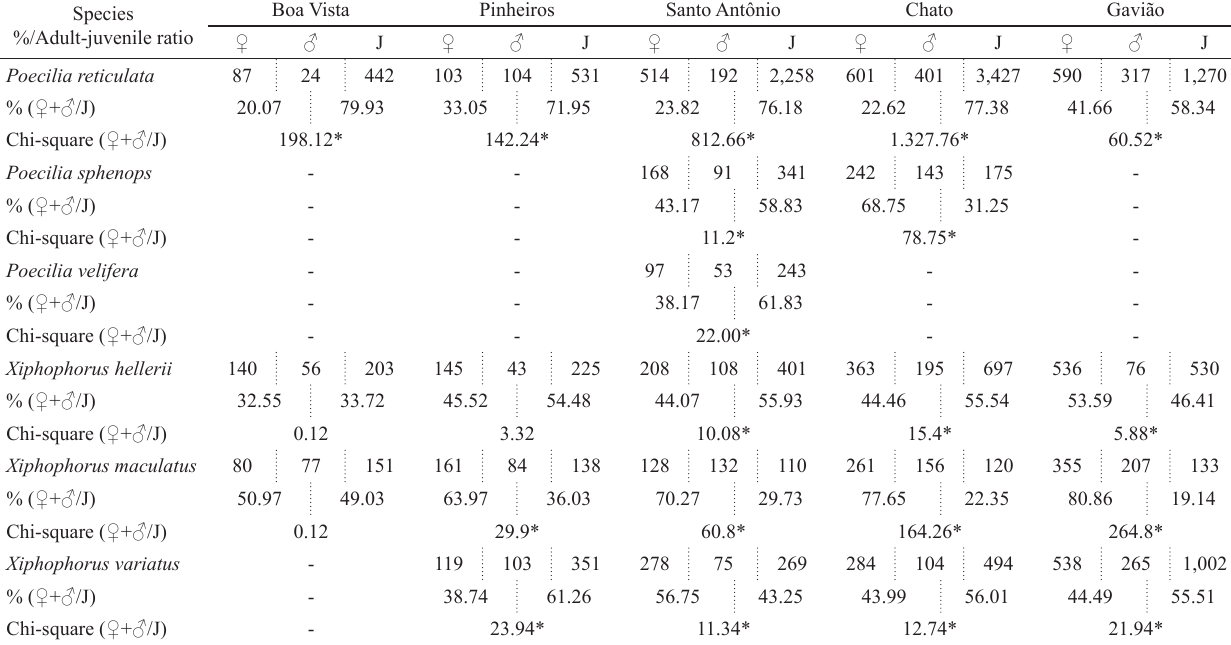
Tab. 2. Total absolute/relative frequencies and adult-to-juvenile ratio of ornamental non-native poeciliid species collected in the creeks in 2003, 2004, 2005 and 2006. Adult (♀+♂), juvenile (J). * Indicates the significant values for adult-to-juvenile ratio (Chi-square, P < 0.05, χ 2 = 3.841, d.f. = 0.05